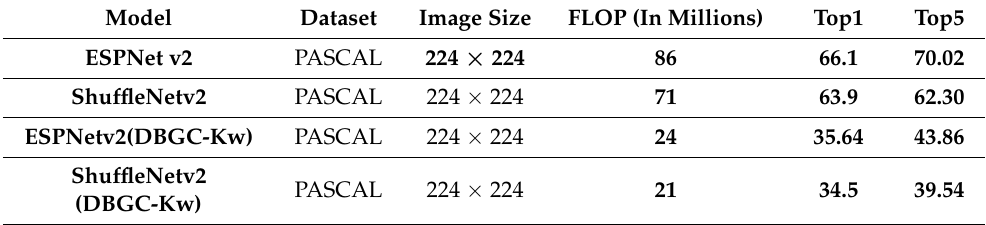
Table 3. Only width-based